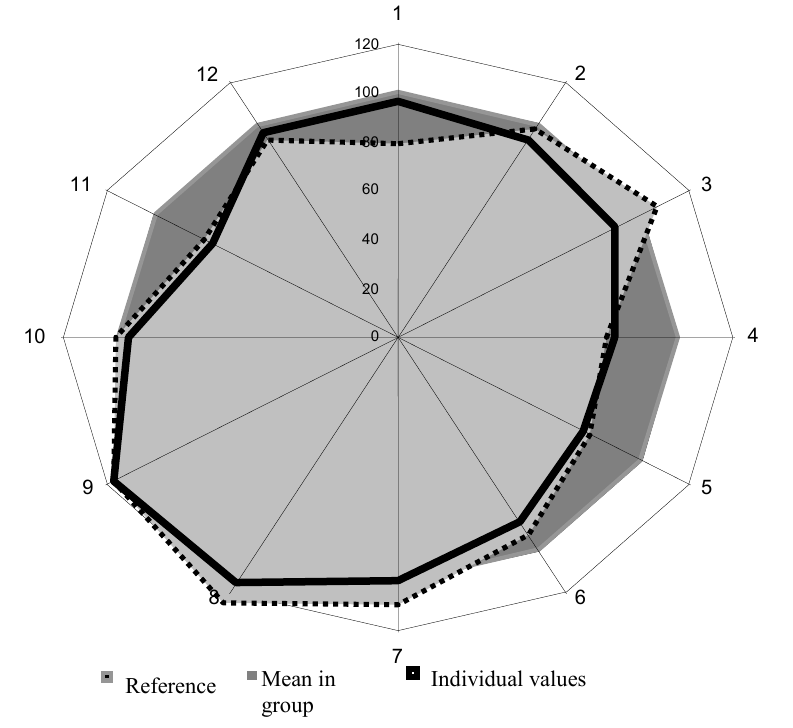
Fig. 2. Functional indicators of ski-racers in conditions, simulating passing competition distance (% from reference value):